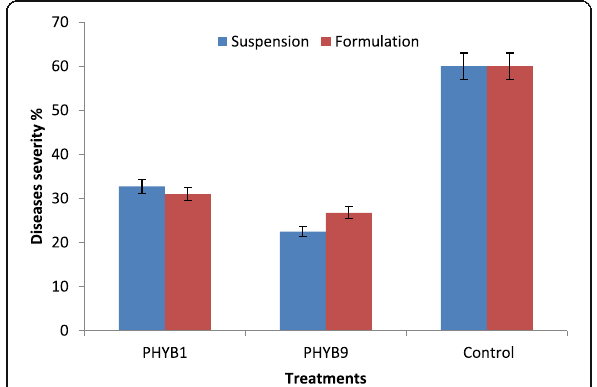
Fig. 1 Effect of Bacillus simplex as suspension and/or formulation on disease severity under greenhouse conditions. Error bars indicate the standard